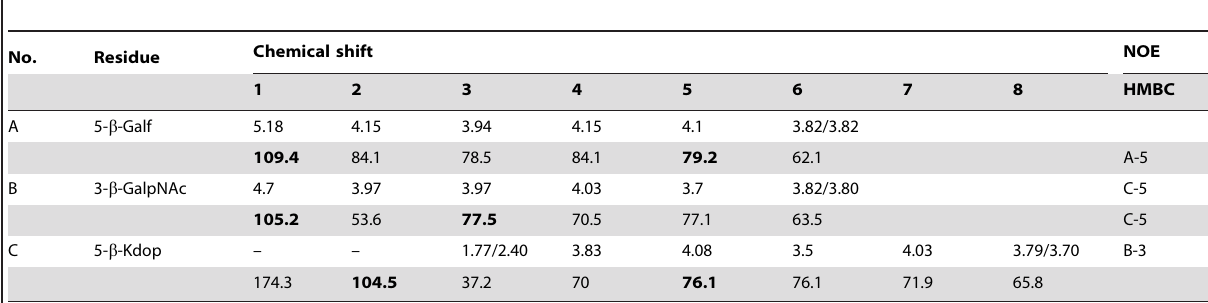
Table 3. Complete chemical shift assignment of the isolated